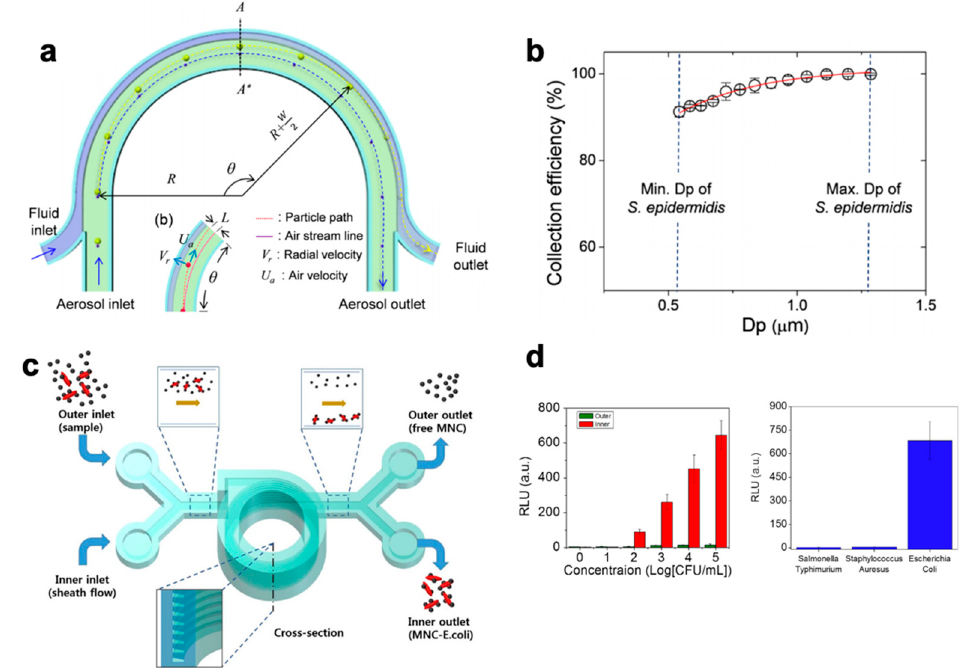
Figure 12. ( a ) The device schematic shows the curved channel and transfer of the aerosolized particles from gas to a fluid. ( b ) Device collection efficiency over the size range of S. epidermidis. ( a , b ) Reprinted with permission from [201]. Copyright 2017, American Chemical Society. ( c ) Microfluidic device design consists of stereolithography 3D printed, stacked spiral microchannel to separate free magnetic nanoparticles from the E. coli-bound particles. ( d ) ATP luminescence measurements show the limit of detection (100 cfu/mL) and organism binding specificity of this enrichment and detection protocol. ( c , d ) Reprinted by permission from Springer Nature: Scientific Reports [202]. Copyright 2015.